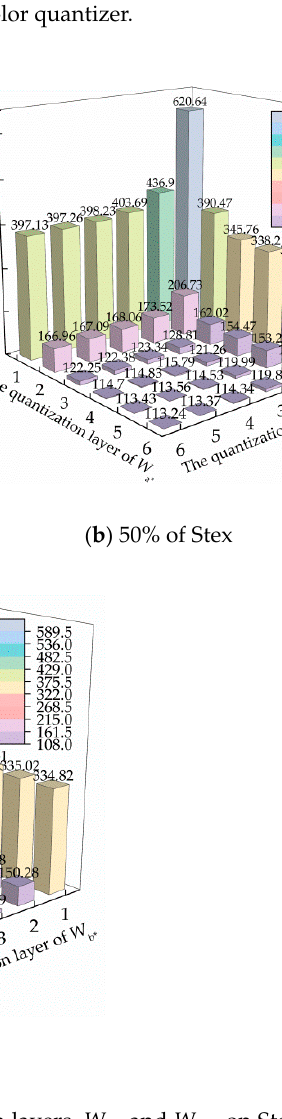
Figure 3. The quantization errors under different quantization layers, W a* and W b* , on Stex and its subsets: ( a ) Stex, ( b ) 50% of Stex, and ( c ) 10% of Stex.